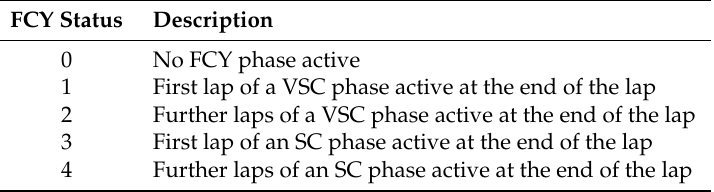
Table 6. Explanation of the full-course yellow (FCY) status